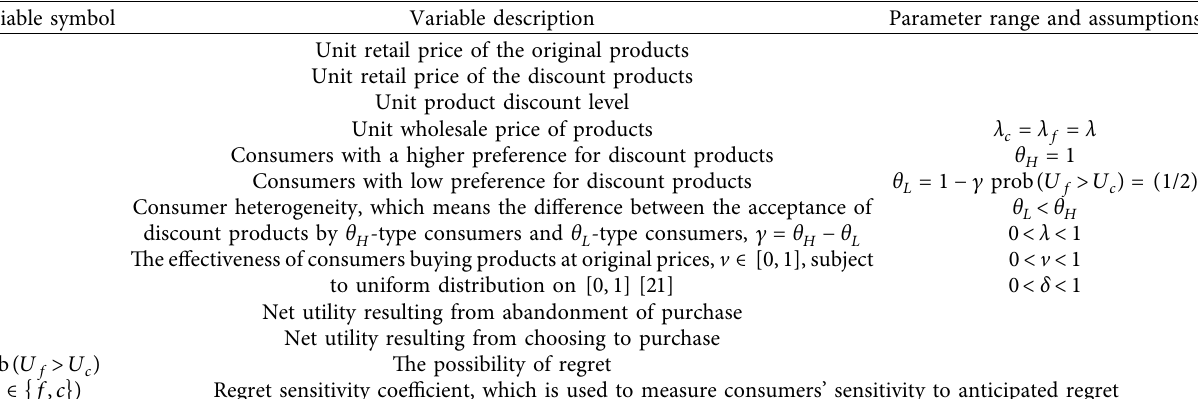
Table 1: Explanation of main symbols and hypothesis.